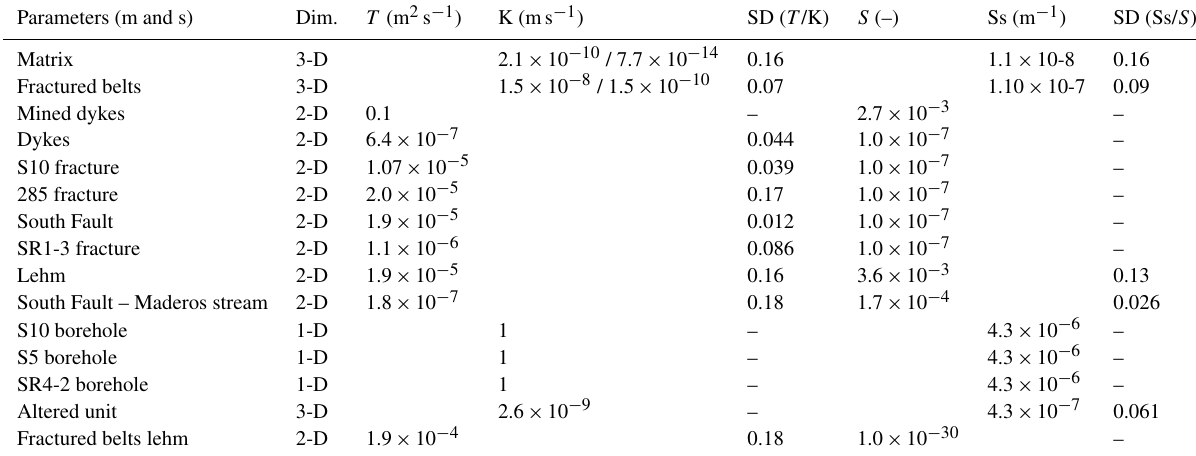
Table 1. Parameters obtained after calibrating the South cross-hole test. Units are meters and seconds, 1-D features are defined in terms of hydraulic conductivity and specific storativity by assigning them a 1m 2 cross-sectional area. Hydraulic conductivity values of matrix and fractured belts change with depth: the first value holds for the upper 250m (constant parameter), the second value applies to the bottom of the domain – both for the matrix and the fractured belts. The storativity of the fractured belts lehm is negligible in the model (1.0 × 10 − 30 ), to prevent the artifact that water might be withdrawn from that zone. Standard deviations (SDs) of the decimal logarithms of estimated parameters (not shown for parameters held constant during calibration) are also presented as a measure of uncertainty. Parameters (m and